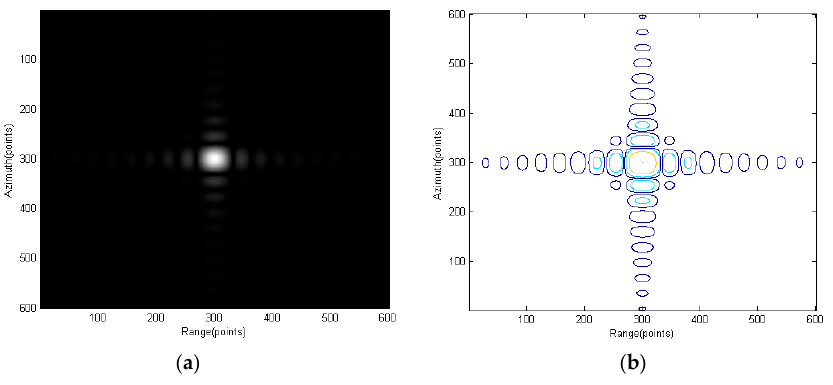
Figure 8. Point G: ( a ) amplitude plot and ( b ) contour plot.